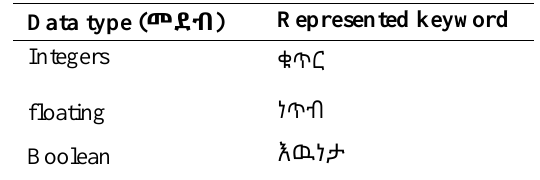
Table 1. Amharic Based Data Types